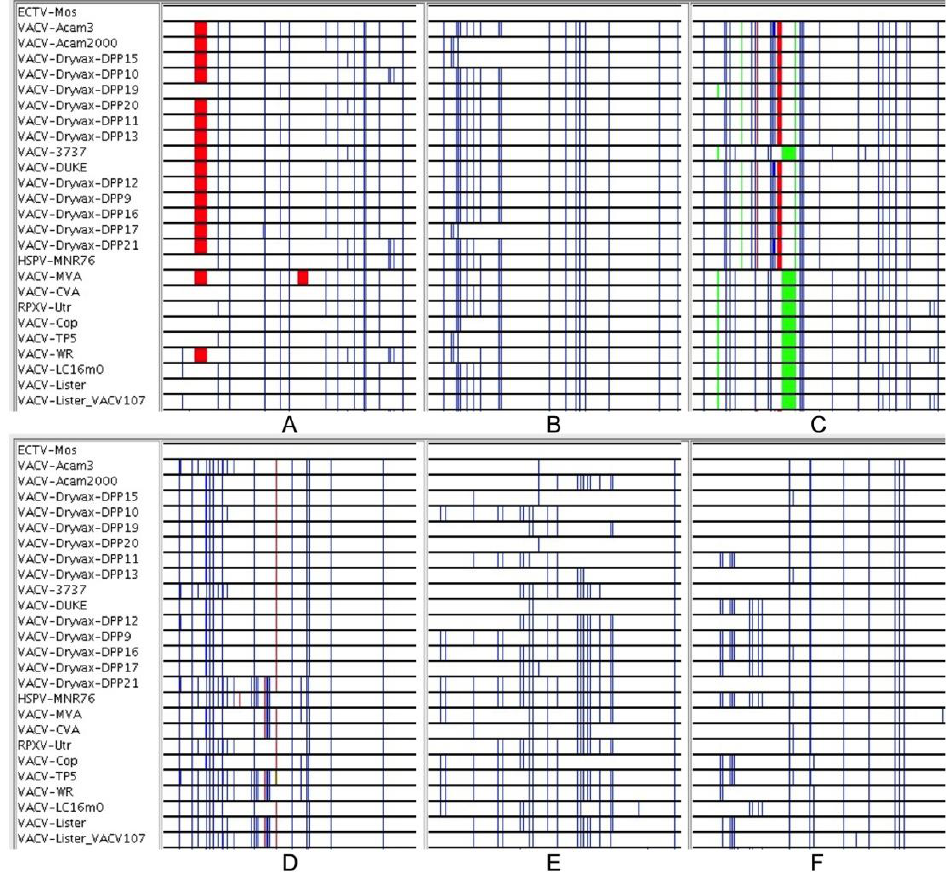
Figure 3. ( A – F ): 350 nt segments of the core alignment (before gapped columns were removed) viewed with the Base-By-Base Visual Summary view. VACV sequences are all compared to ectromelia virus: Blue lines show SNPs; red and green show deletions and insertions,